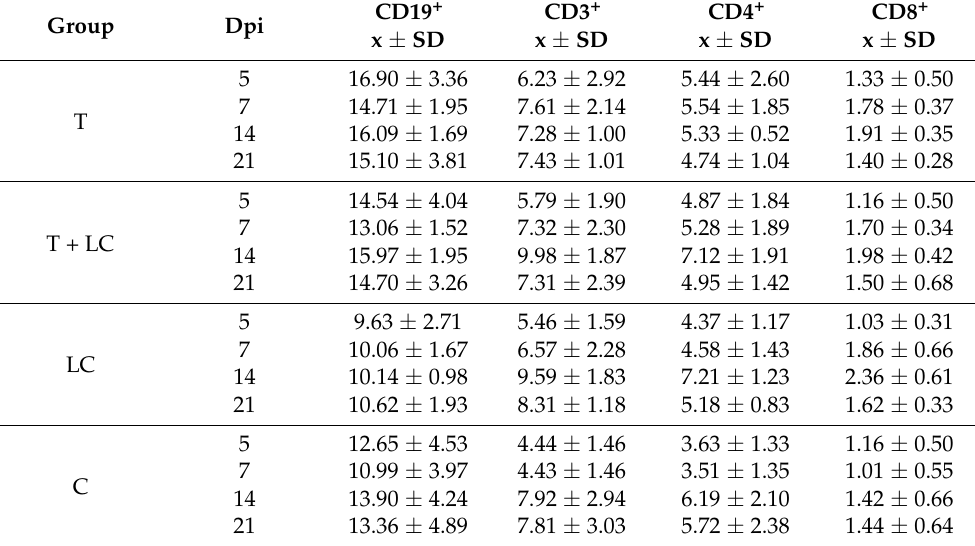
Table 2. Absolute count (cells × 10 6 ) of splenocyte B (CD19 + ) and T (CD3 + , CD4 + , CD8 + ) subpopula- tions in the mice infected with T. spiralis (Group T), infected with T. spiralis and receiving LC (Group T + LC), uninfected with T. spiralis and receiving LC (Group LC), and uninfected mice (control) (Group C). Mean values ( n = 6) and standard deviations are